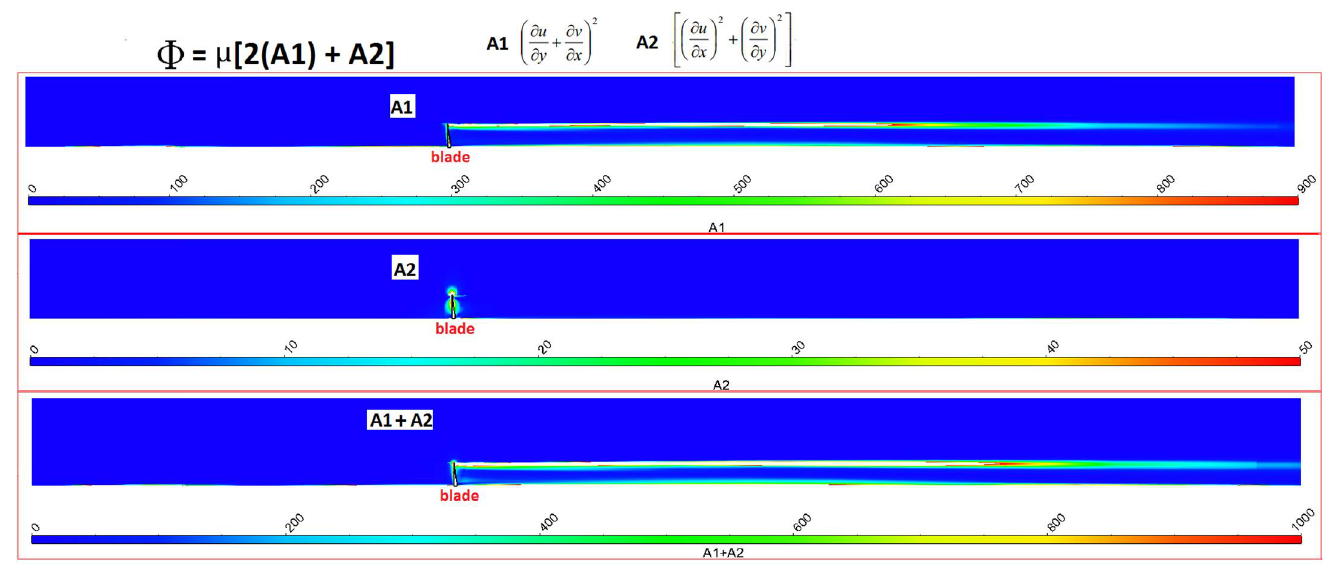
Figure 23. Normalized properties integrated over an area of radius 1 m (> rotor radius) and downstream of the rotor as a function of rotor diameter for 20R-20R-70R domain.